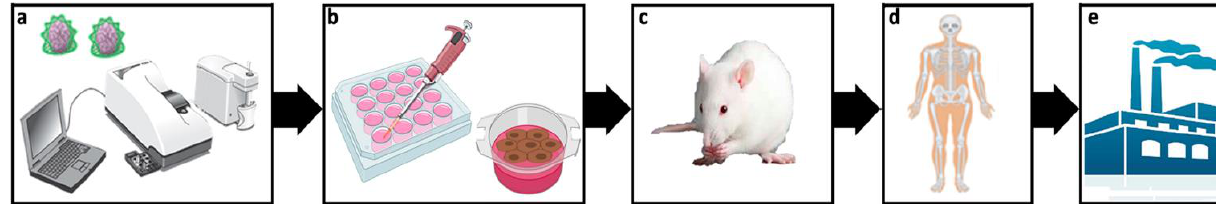
Figure 3. Clinical phases of 3180 ongoing trials based on gene therapy (adapted from http://www.genetherapynet.com/clinical-trials.html; accessed 1 June 2021; gene therapy clinical trial database).